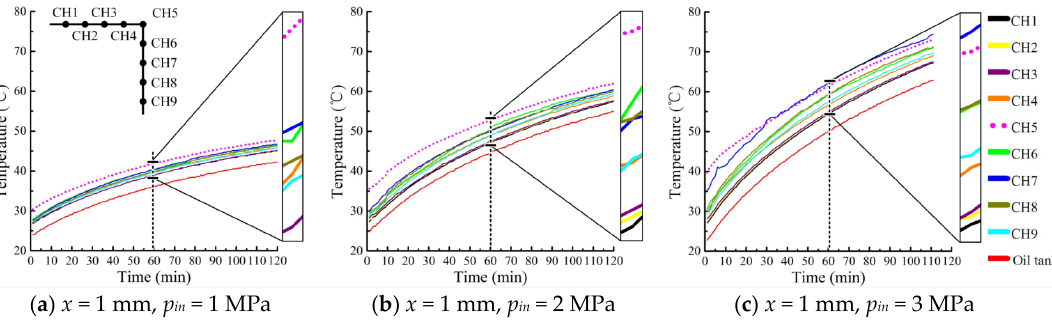
Figure 6. Temperature curves of the valve orifice with different pressures in the experiment.